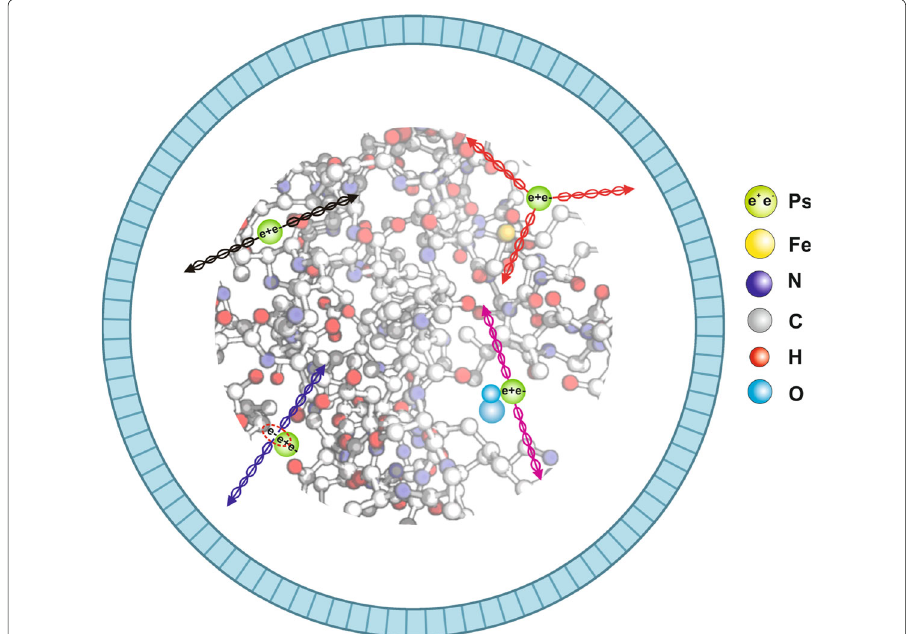
Fig. 1 Pictorial representation of the single detection ring of the positron emission tomography scanner and (not to scale) magnified part of the hemoglobin molecule with pictorial representation of the possible ways of decays of positronium atoms (Ps) trapped in the intramolecular voids. Left-upper (black arrows) and right-upper (red arrows) indicate annihilations in the space free of electrons for para-positronium and ortho-positronium, respectively. Annihilation of positronium through the interaction with the electron from the surrounding molecule is shown in the left-lower corner (violet arrows) while in the right-lower part